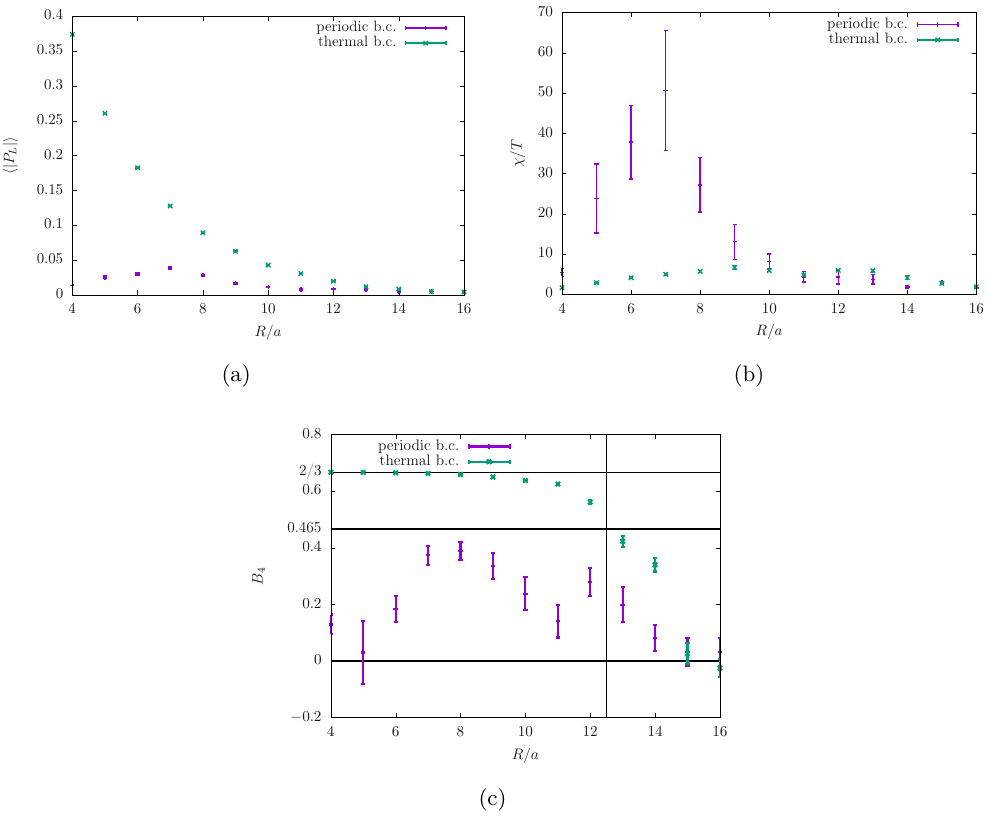
Figure 6 . The results for the Polyakov loop at β = 1 . 75, κ = 0 . 14925, c sw = 0 on a 24 3 × N t lattice as a function of N t = R/a . The plots show a comparison of periodic and thermal fermion boundary conditions in the same way as in figure 4: (a) the average modulus of the Polyakov loop | P L | , (b) the susceptibility of P L , and (c) the Binder cumulant. In these simulations one level of stout smearing was applied to the gauge links in the Dirac operator. The physical observables at these parameters can be found in